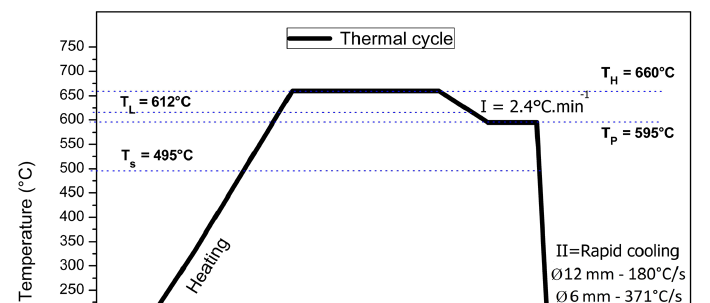
-Processing temperature. P